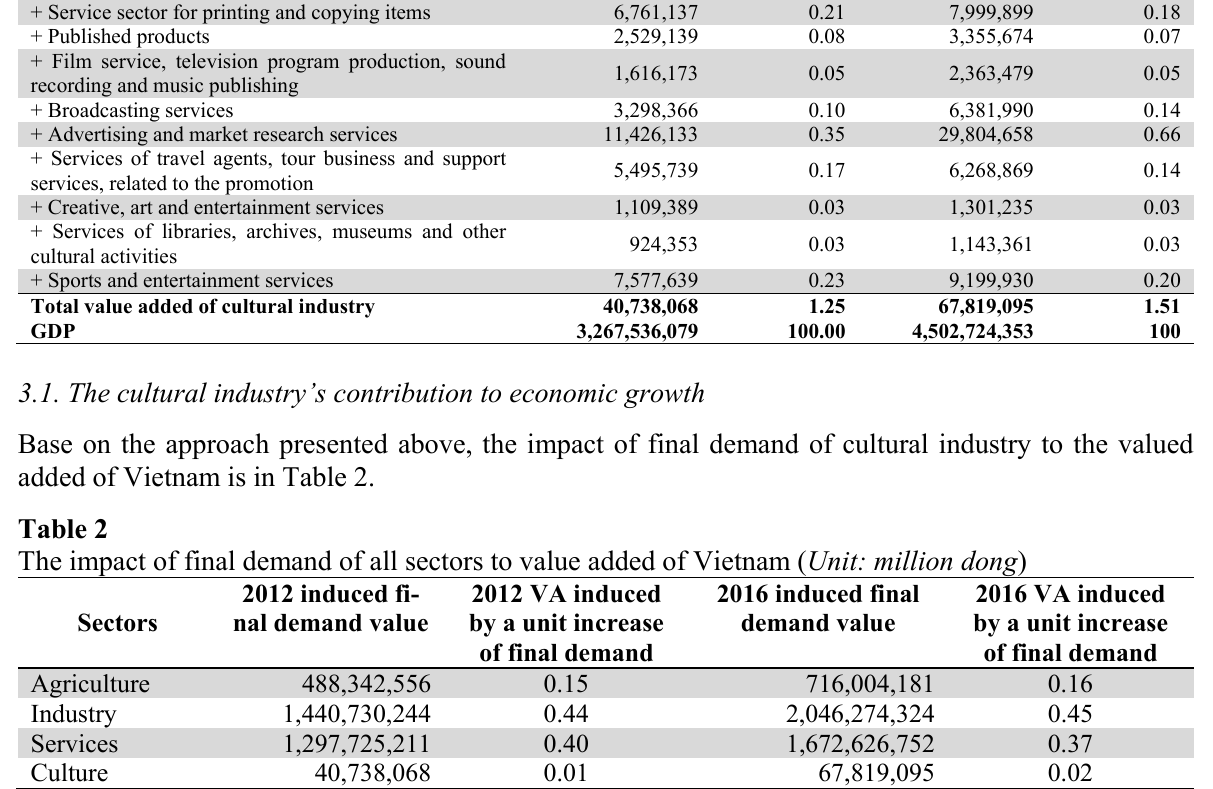
+ Service sector for printing and copying items